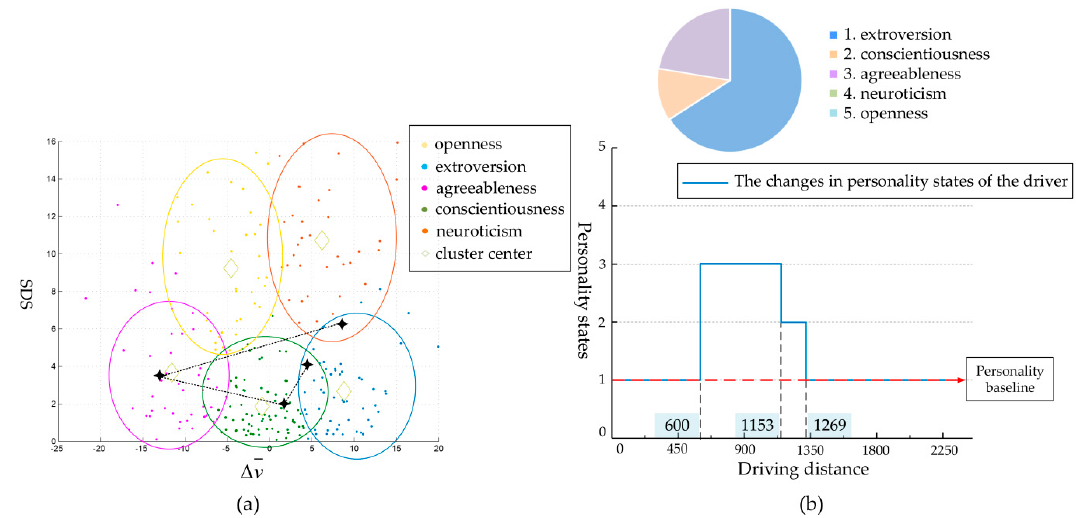
Figure 6. Changes in the personality states of the tested driver in the risk-free scenario. ( a ): The changing line of personality states in the driver’s continuous driving experiment; ( b ): Proportion diagram of five personality states in the risk-free scenario, and the changes of personality states with driving distance.